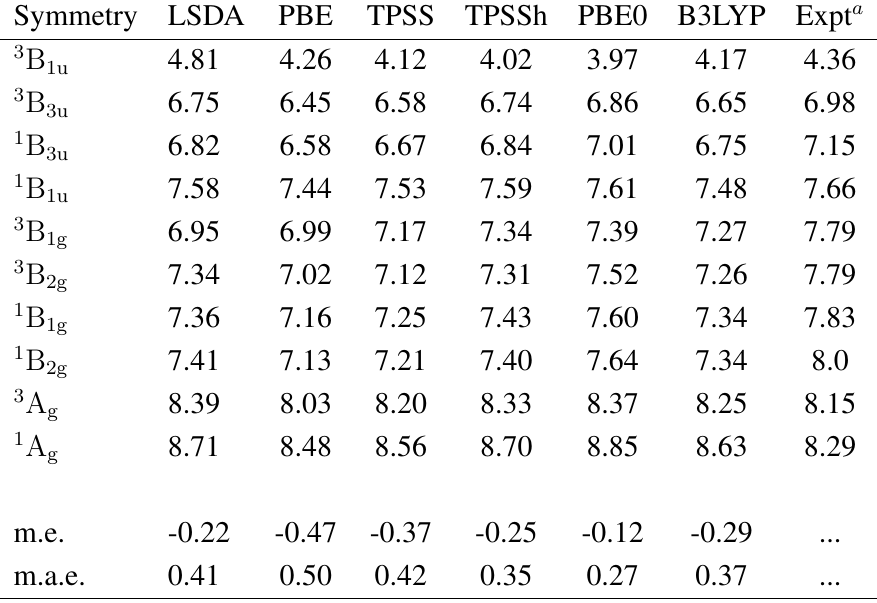
Table 7. The same as Table 2, but for ethylene (C 7.40 eV.